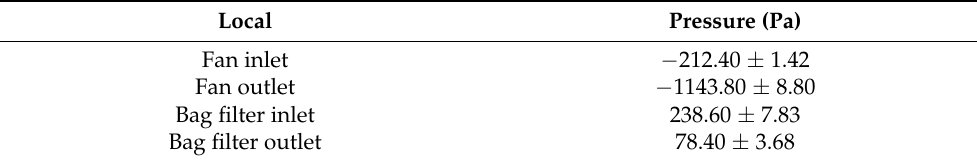
Table 2. Results of the experiments with an uncertainty for 95% confidence